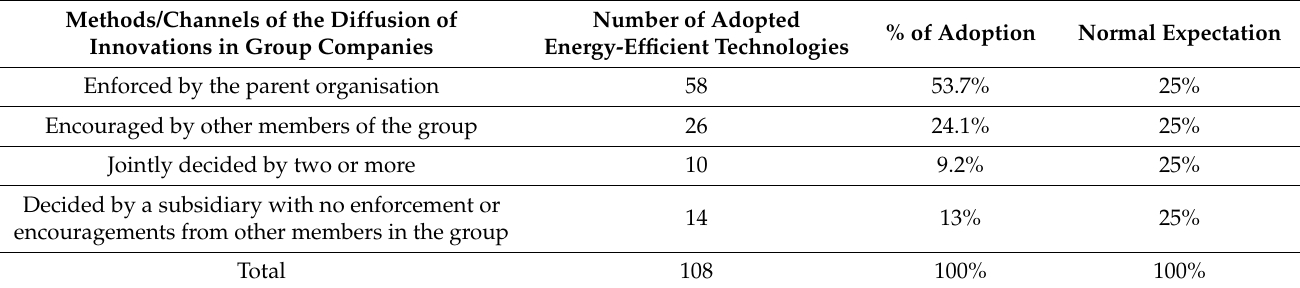
Table 1. The implementation of sustainable and energy-efficient technology in organisations and their sources. Methods/Channels of the Diffusion of Innovations in Group